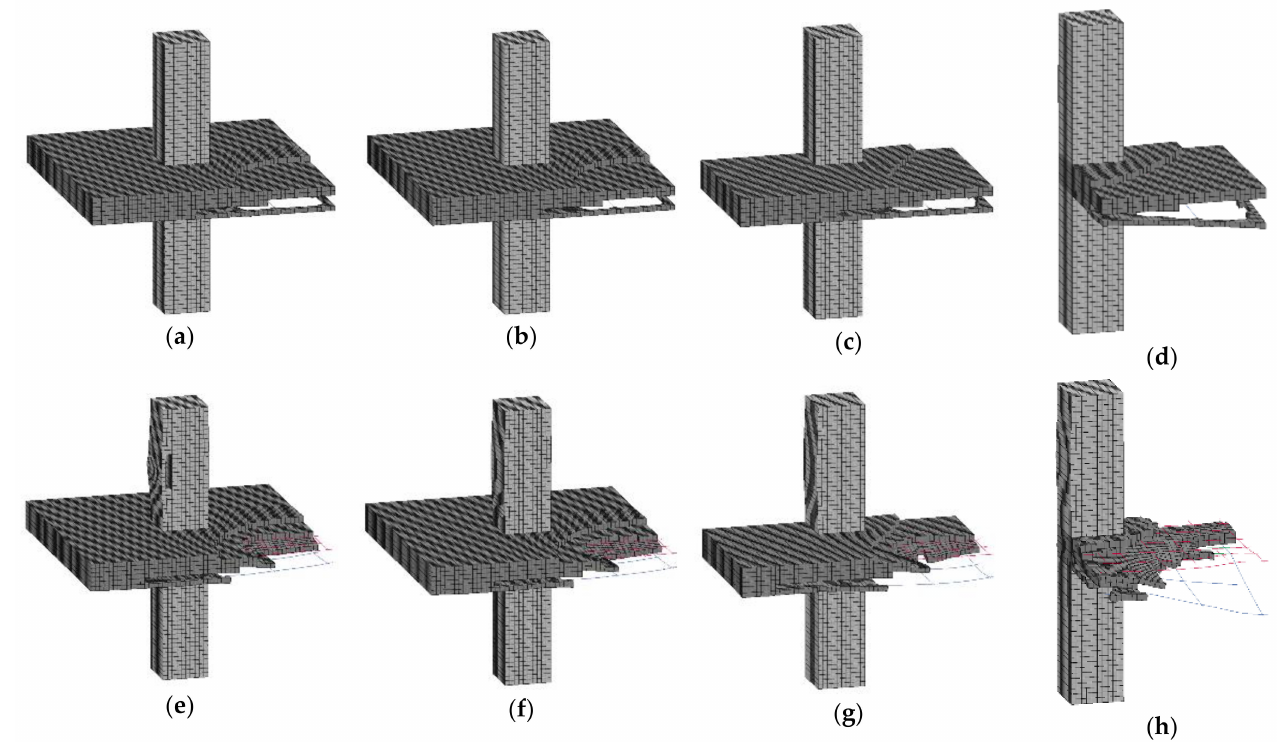
Figure 5. Failure shape of slab–column connections: ( a ) specimen IC4; ( b ) specimen IC-D4; ( c ) specimen EC4; ( d ) specimen CC4; ( e ) specimen IC12; ( f ) specimen IC-D12; ( g ) specimen EC12; ( h ) specimen